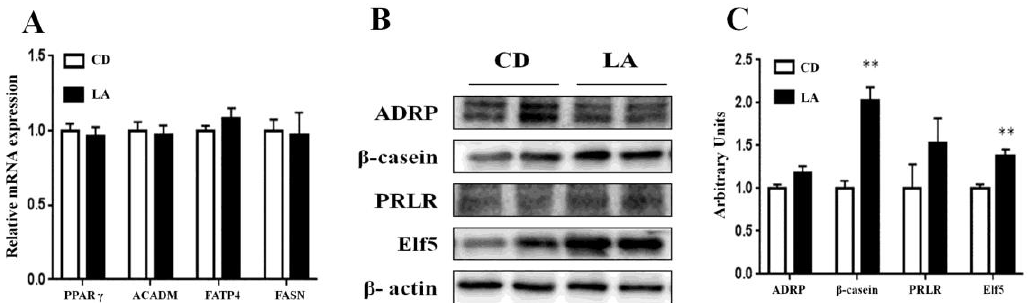
Figure 3. The effects of dietary supplementation of 1% LA on the relative gene expressions in the mammary glands of lactating mice. ( A ) The relative mRNA expression levels of FASN, PPARγ, FATP4, and ACADM in mammary glands (n = 4). ( B ) Western blot analysis of ADRP, β -casein, PRLR, and Elf5